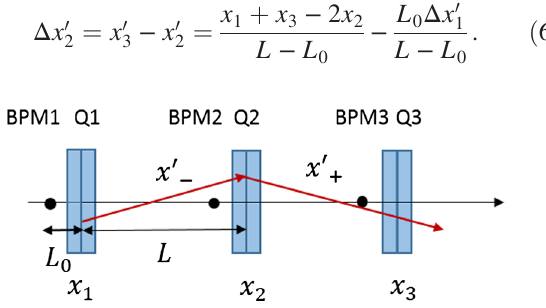
FIG. 2. Casewitha smalldistancebetweenBPM